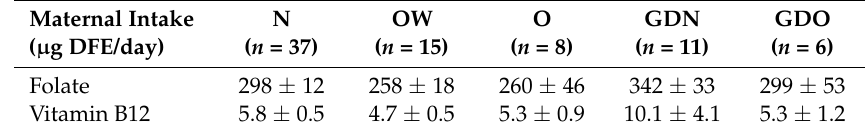
Table 3. Mean maternal 7 day dietary intake of folate and vitamin B12 between 34–40 weeks gestation for each group of women whose body weight category was defined according to their pre pregnancy BMI.